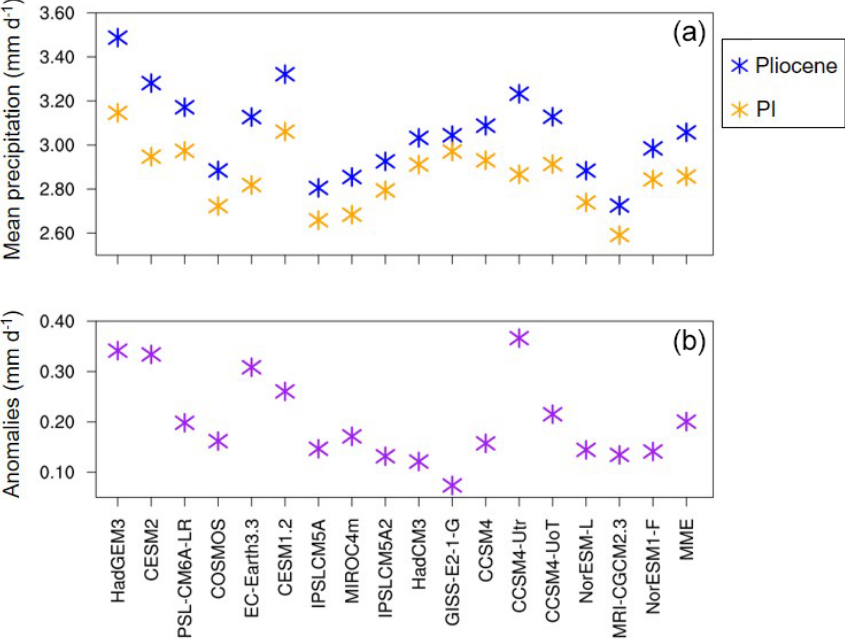
Figure 13. Global annual mean surface precipitation (a) and anomalies (b) from the HadGEM3 mPWP simulation and all other models in PlioMIP2, as well as multi-model ensemble mean (MME). Figure reproduced and adapted from Haywood et al. (2020).